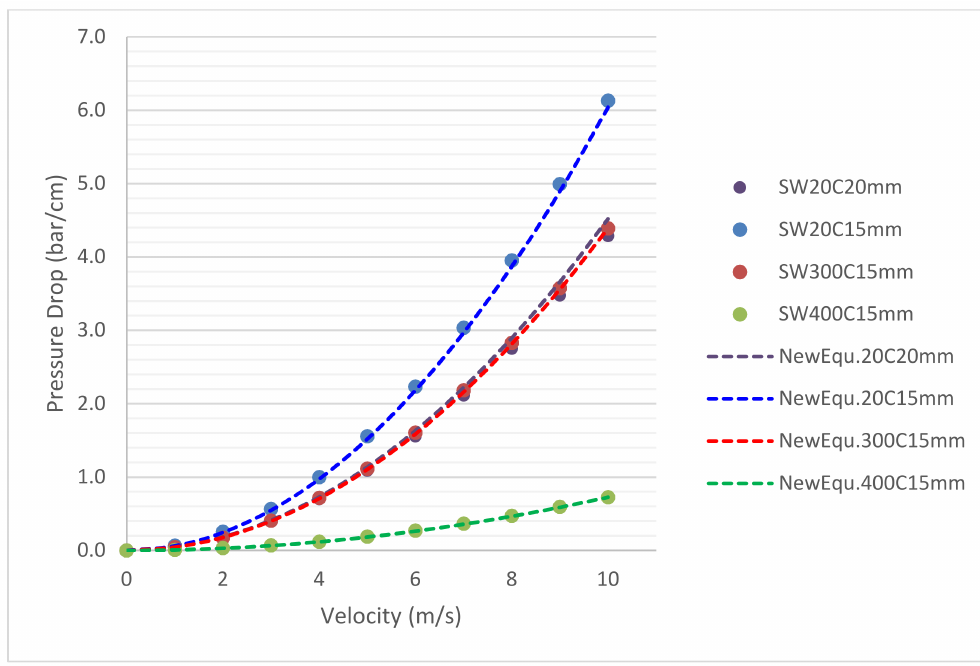
Figure 21. SolidWorks results compared with expected pressure drop with new provided